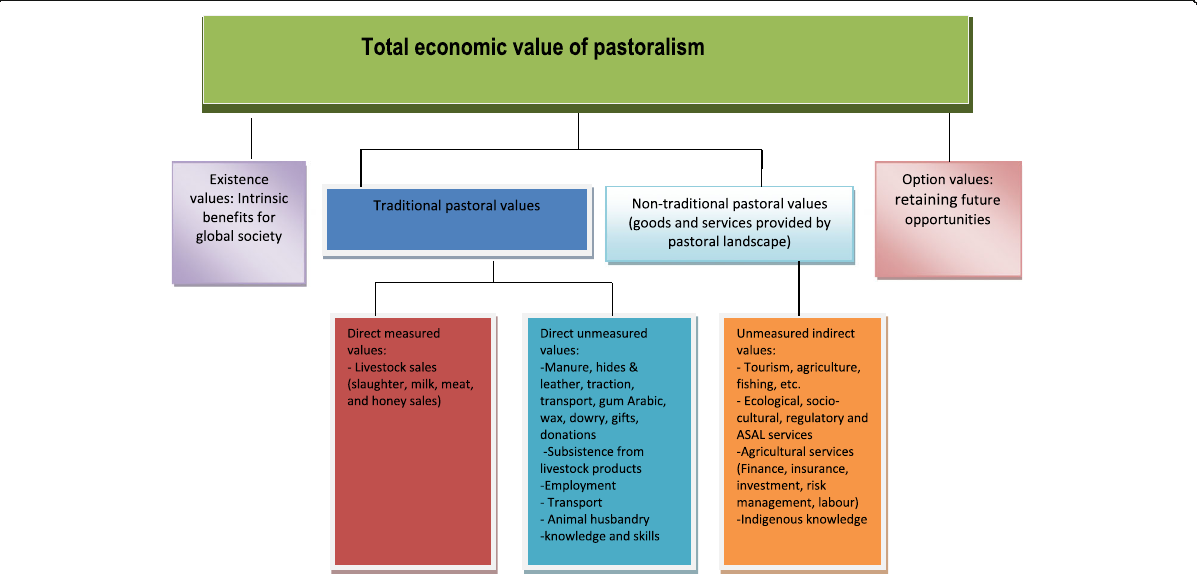
Fig. 1 Conceptual framework for total economic valuation of pastoralism. Source: modified from Hesse and MacGregor 2006 and Davis